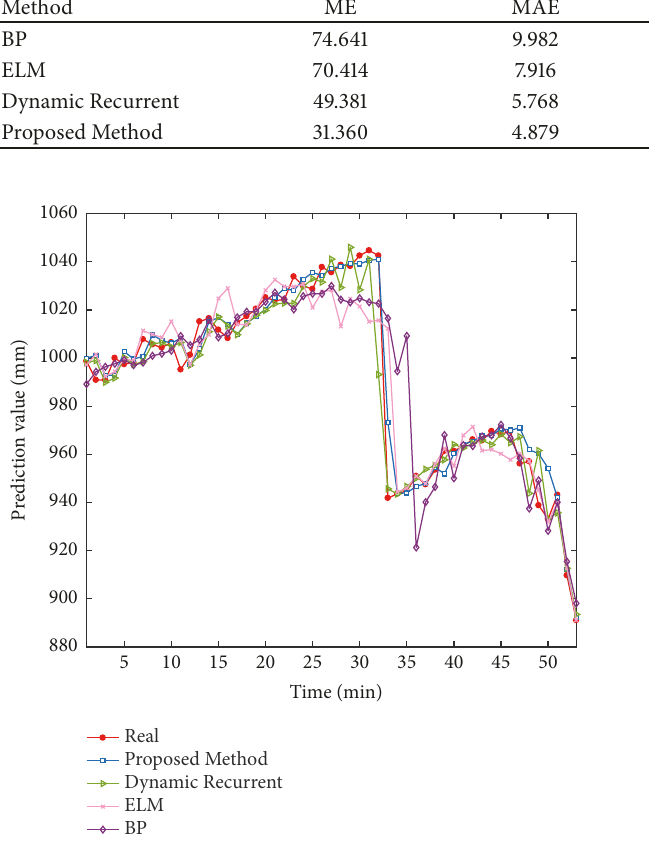
Figure 9: Prediction results of key parameters.